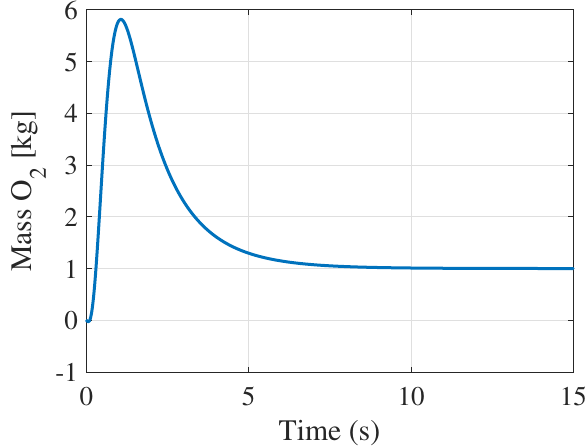
Figure 4. LQR design simulation results for m O